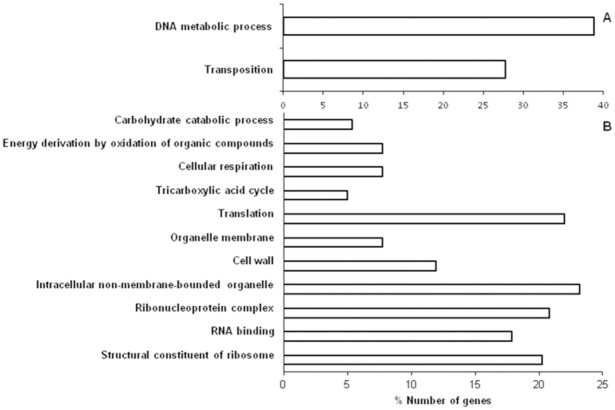
Genes up regulated (%) in E. coli LSP cells compared with SP cells of E. coli which were both sub-cultured in LB based on biological process classification reported by Gene ontology term functional categories using DAVID version 2.0 software (A).Genes down regulated (%) in E. coli LSP cells compared with SP cells of E. coli which were both sub-cultured in LB based on biological process classification reported by Gene ontology term functional categories using DAVID version 2.0 software (B).